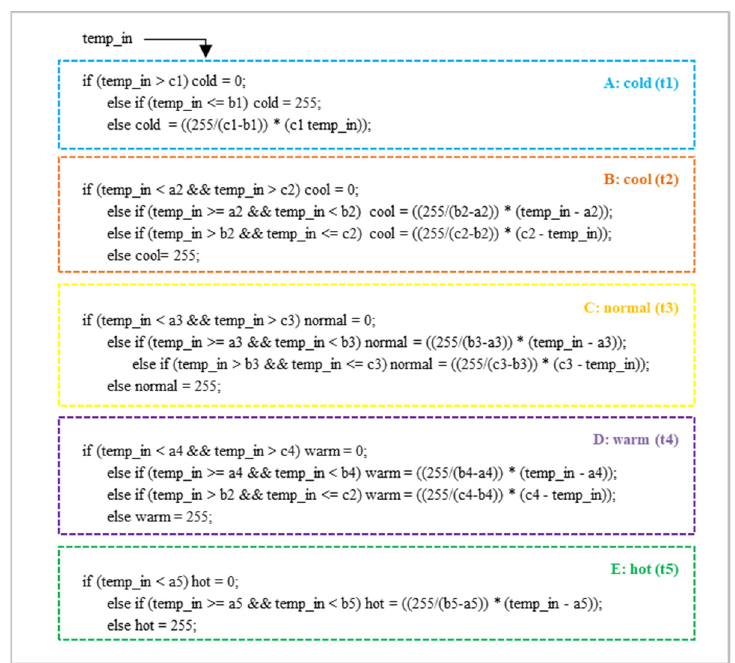
Figure 4. Representation of the algorithm for the temp_in module corresponding to the temperature (T) fuzzification.